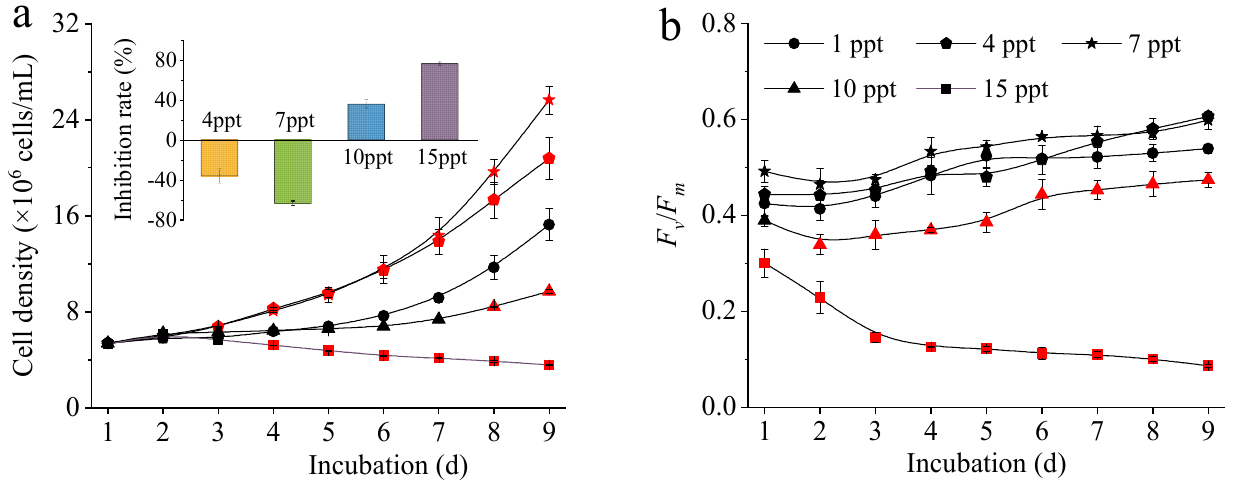
Figure 2. Changes in M . aeruginosa cell density and the inhibition rate of cell growth ( a ) and F v / F m ( b ) during the experiment under different salinity stresses. Red-filled legends indicate significant differences compared to the control (ANOVA, p < 0.05).